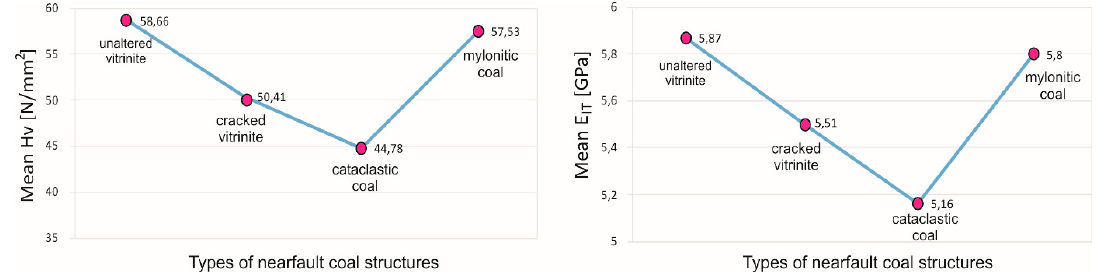
Figure 6. The mean values determined from all the measurements of microhardness H V and the elasticity module E IT .